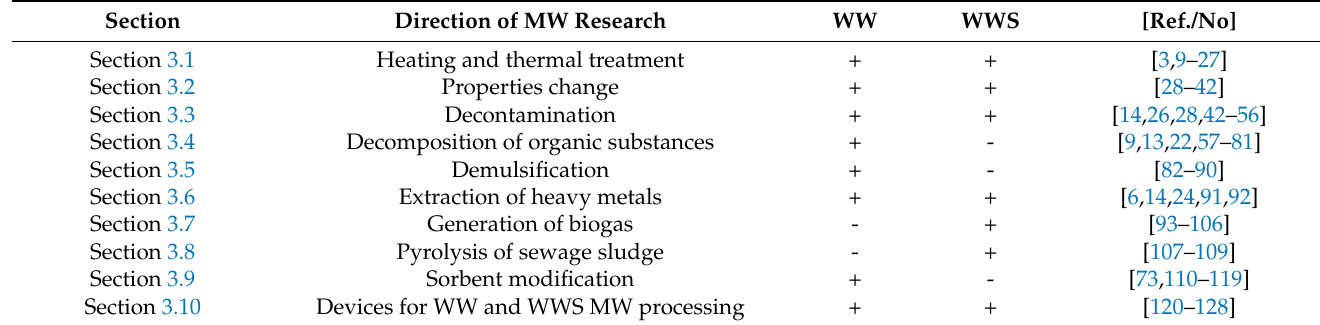
Table 1. Key research directions on the use of MW in WW and WWS processing